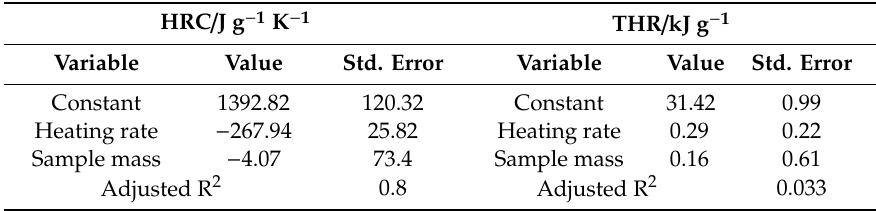
Table 5. Summary of regression analysis.